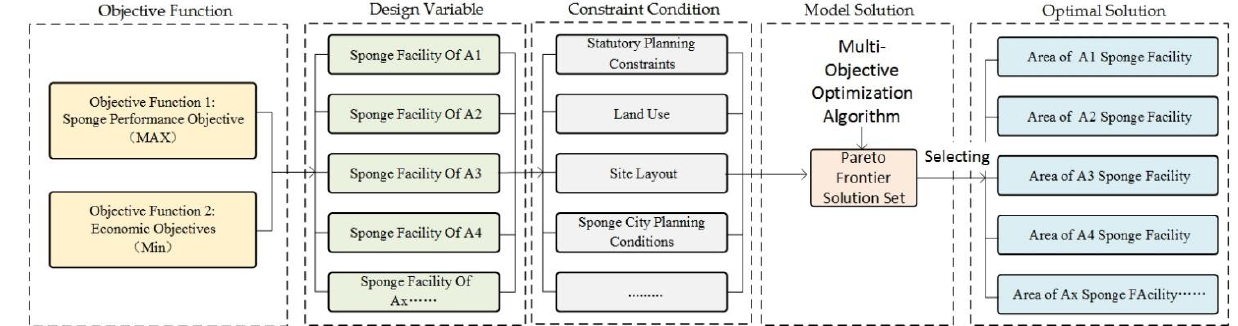
Figure 1. A logical framework for a multi-objective optimization model of sponge facilities com- bination